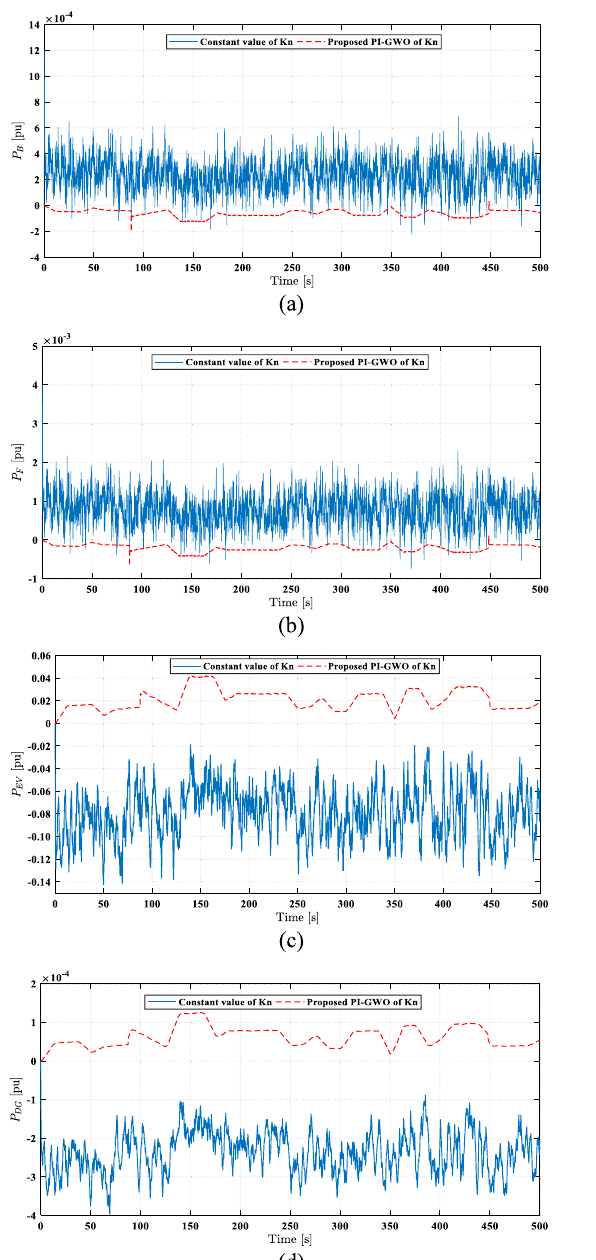
Fig. 21 The performance of HGS sources for Case 4 a battery power, b flywheel power, c EV power, and d DG power